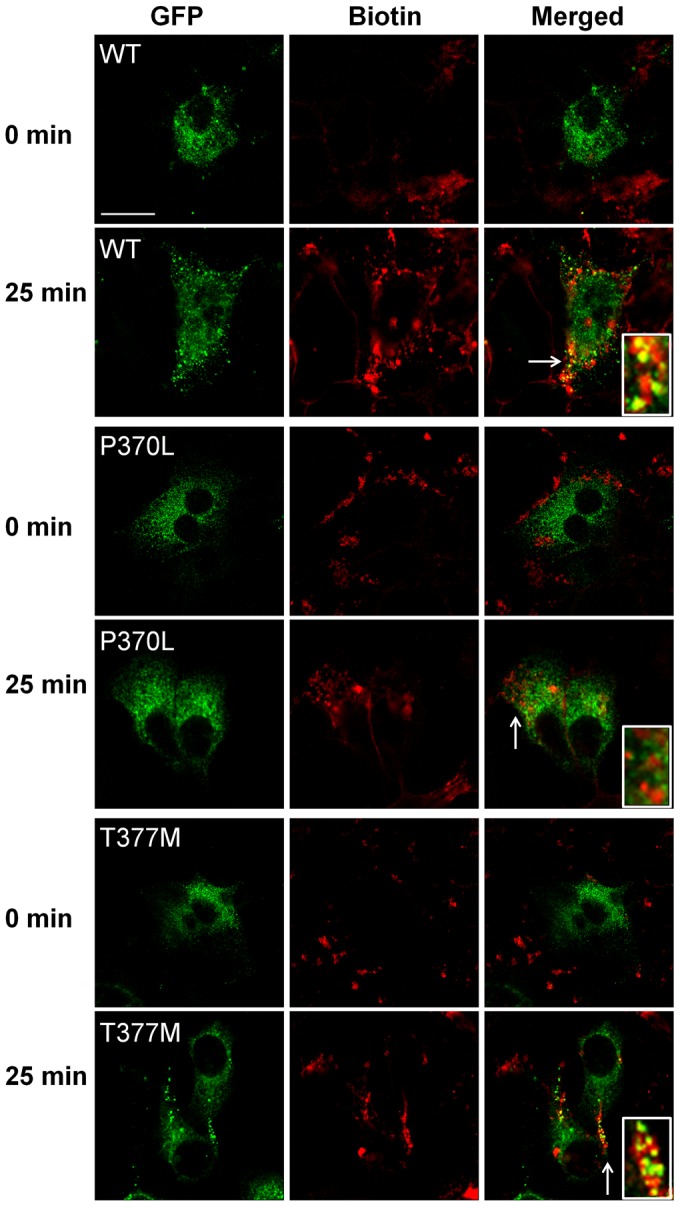
Co-localization of myocilin and endocytosed membrane proteins after GPCR stimulation.Cell surface proteins of MCF7 cells expressing myocilin (WT, P370L, or T377M) linked to GFP (green) were biotinylated. Cells were stimulated for 25 minutes with L-DOPA or remained untreated (time zero), and residual cell surface biotin was cleaved by disulfide reduction. Cells were fixed, labeled with rhodamine streptavidin (red) and imaged by confocal microscopy. Insets represent a 4-fold magnification of the cellular region identified by the arrow. Results are representative of 5 experiments conducted in MCF7 cells. Bar  =  25 µM.